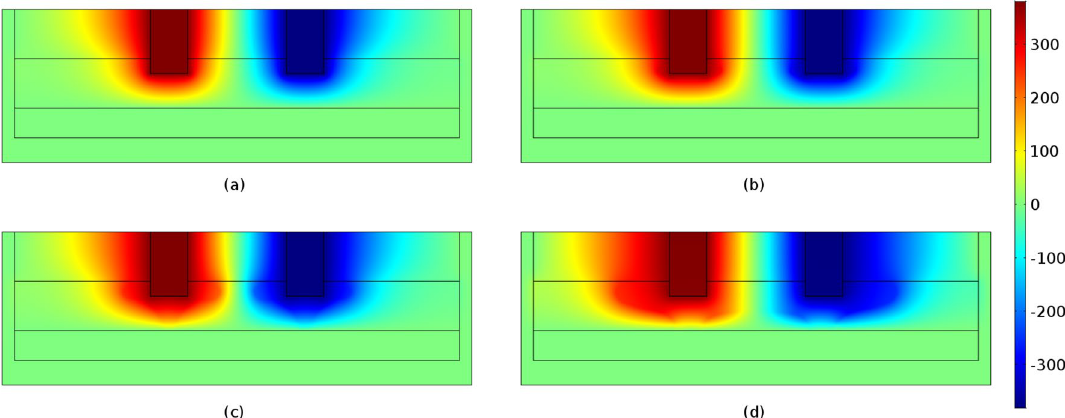
Figure 6. Potential distribution (V) at times equal to ( a ) 2500 s, ( b ) 5000 s, ( c ) 7500 s and ( d ) 10,000 s. The maximum absolute values are determined in the vicinity of the electrode tips and monotonically decreases to ground potential (0 V) values.